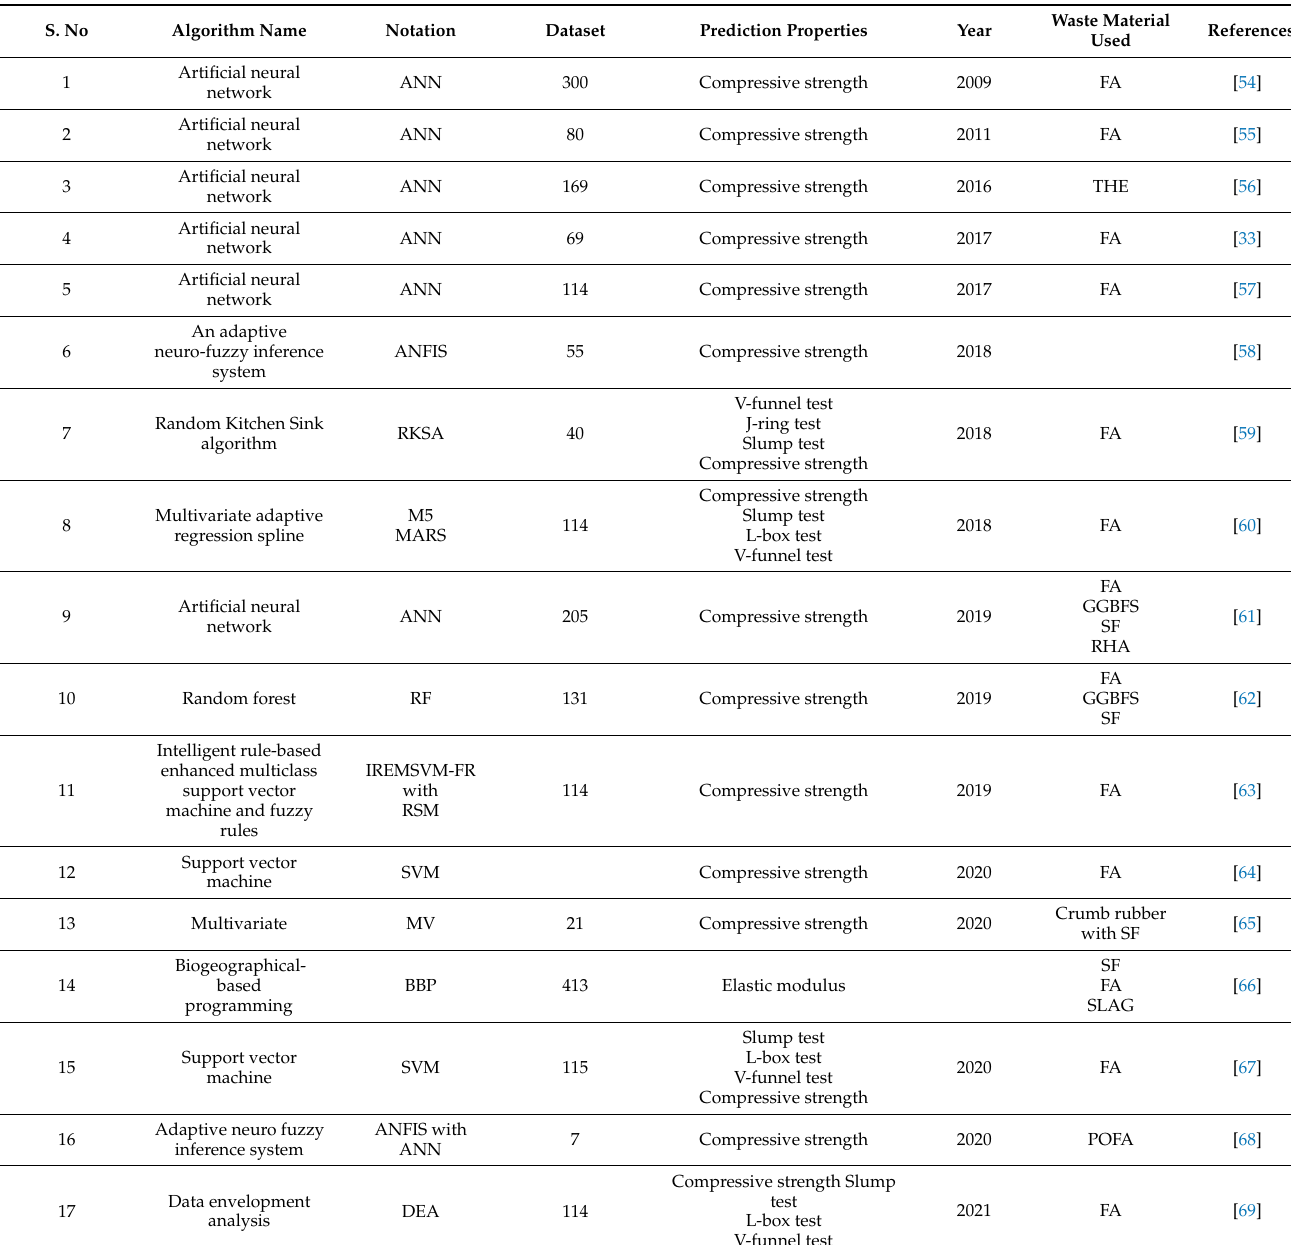
Table 1. Prediction of Concrete Properties by using Waste